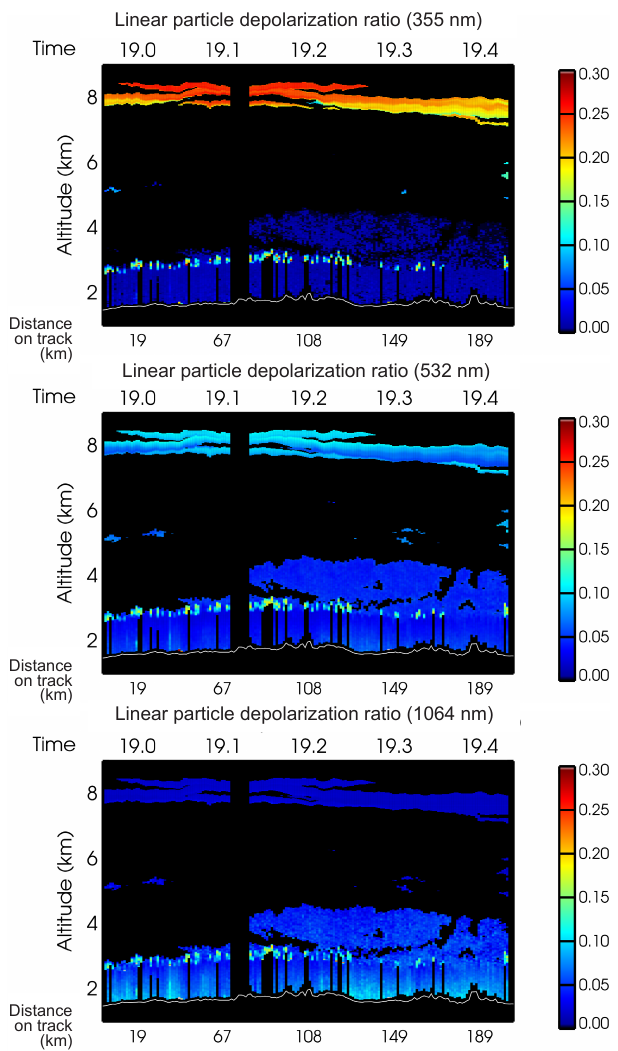
Figure 13. The linear particle depolarization ratio measurement curtains for the flight segment shown in Fig.